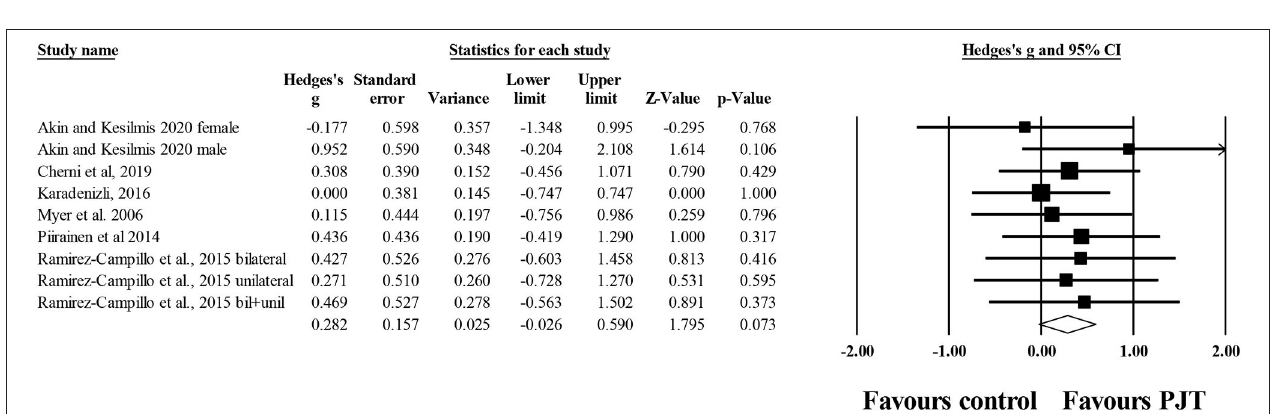
FIGURE 4 | Forest plot of changes in dynamic balance, measured through field-based tests, in participants that completed a plyometric jump training (PJT) program compared to participants allocated as controls. Values shown are effect sizes (Hedges’s g) with 95% confidence intervals (CI). The size of the plotted squares reflects the statistical weight of each study. The diamond reflects the overall result.